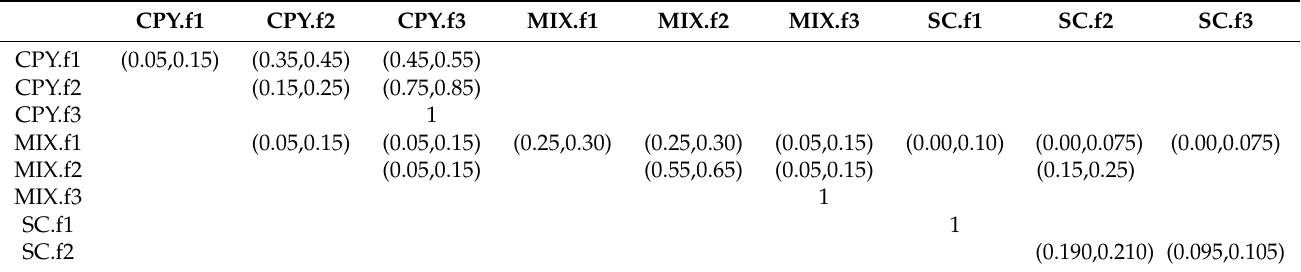
Table 4. Conversion in grinding 1, range of uncertainty U(a,b).